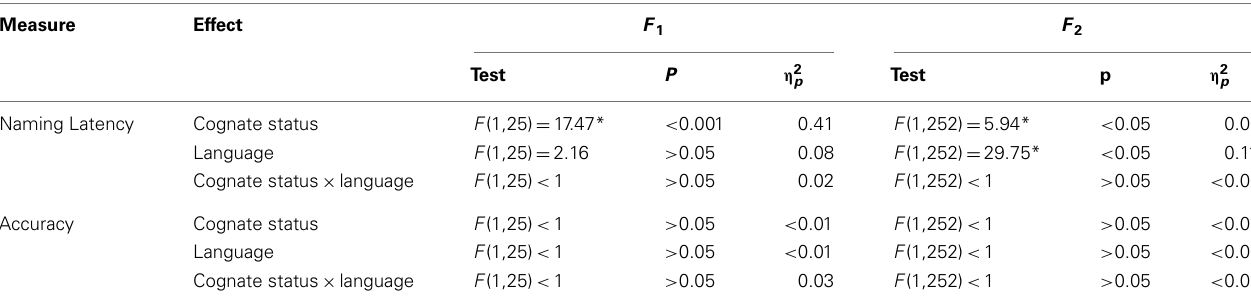
Table 5 | Blocked languageANOVA results.